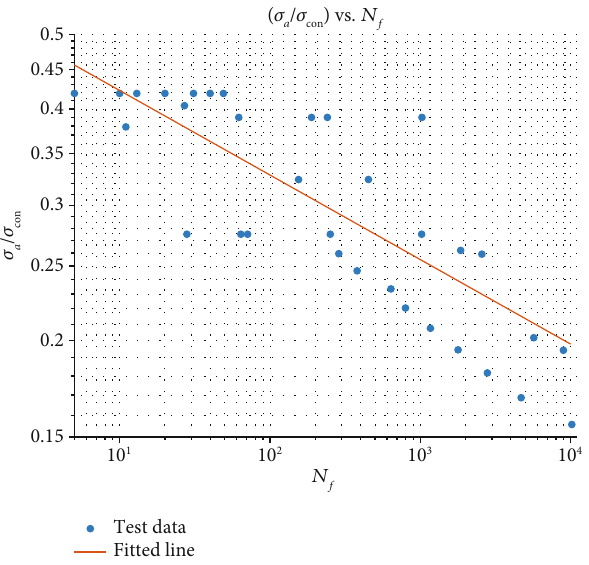
σ versus N f for dry cyclic tests. The red line is the a / con